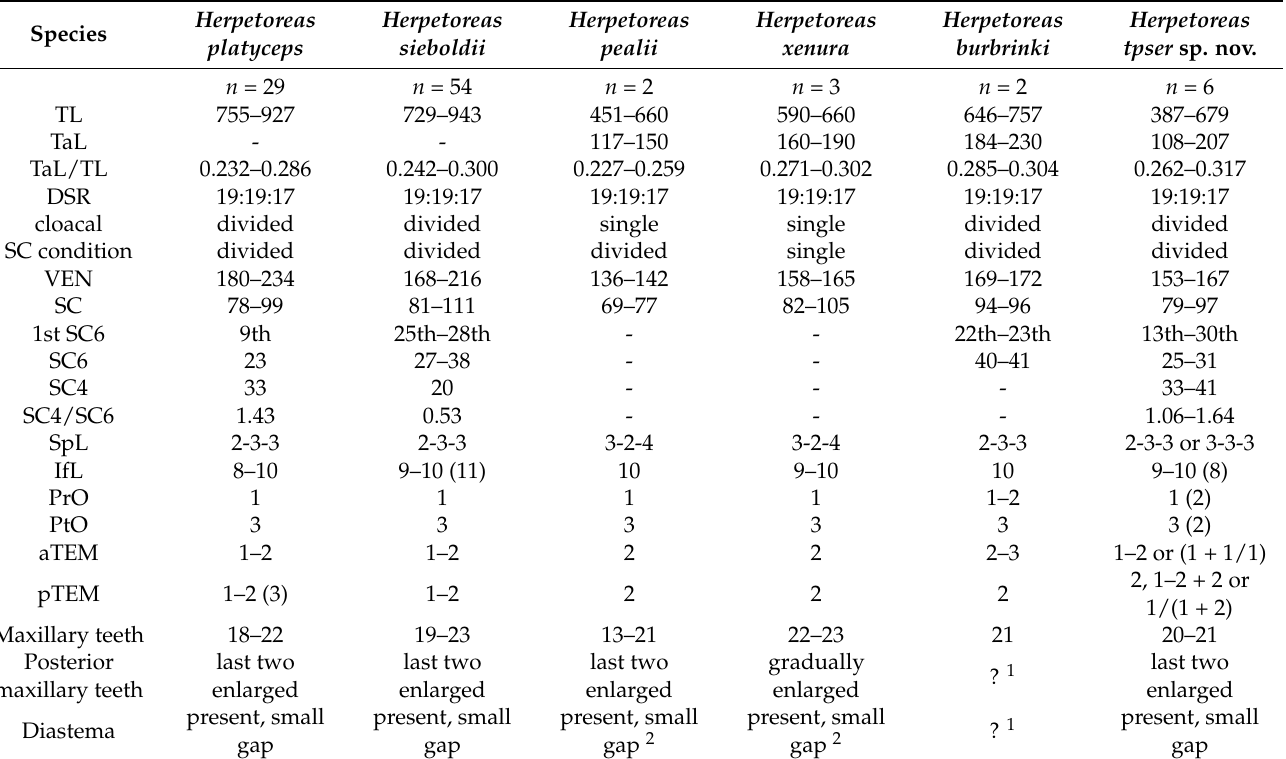
Table 2. Morphological comparisons among congeners of the genus Herpetoreas . “-” indicates missing